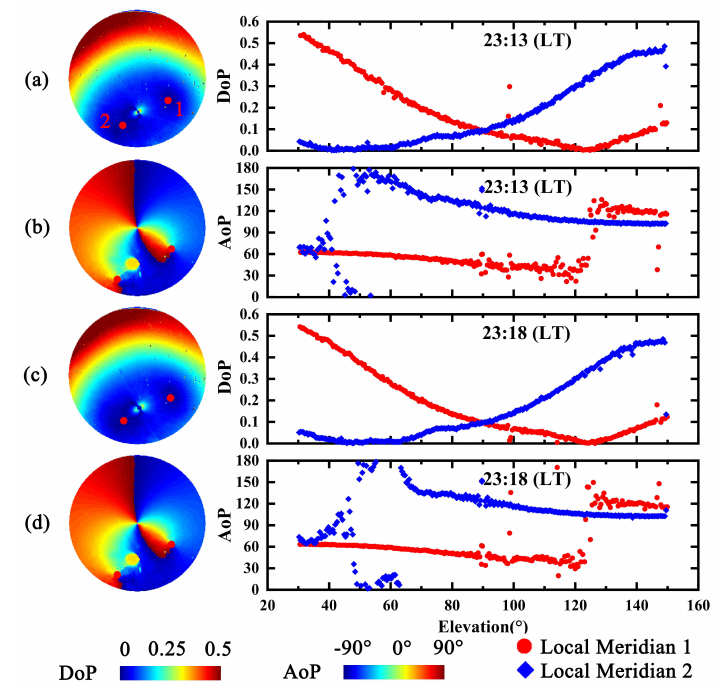
Figure 6. Degree of Polarization (DoP) and Angle of Polarization (AoP) of the Super Blue Blood Moon (SBBM) night at 23:13 Local Time (LT) [( a , b ) and 23:18 (LT) ( c , d ). The geometric centers of unpolarized area in the DoP graphs are represented by the red points. The red points with uncertain AoP directions are shown in the AoP graphs. Red points located at the bottom right corner are expressed as Neutral Point 1 and at the bottom left corner as Neutral Point 2. The DoP and AoP along the local meridian passing through red Points 1 and 2 are shown on the